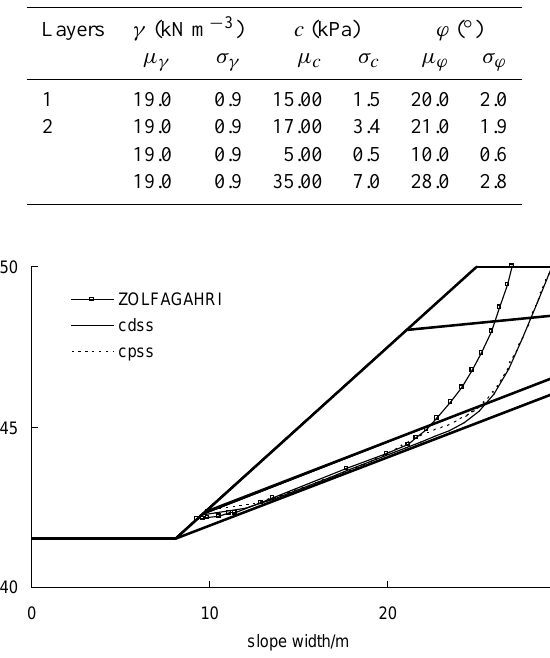
Figure 14. Cross section of Zolfaghari slope in example